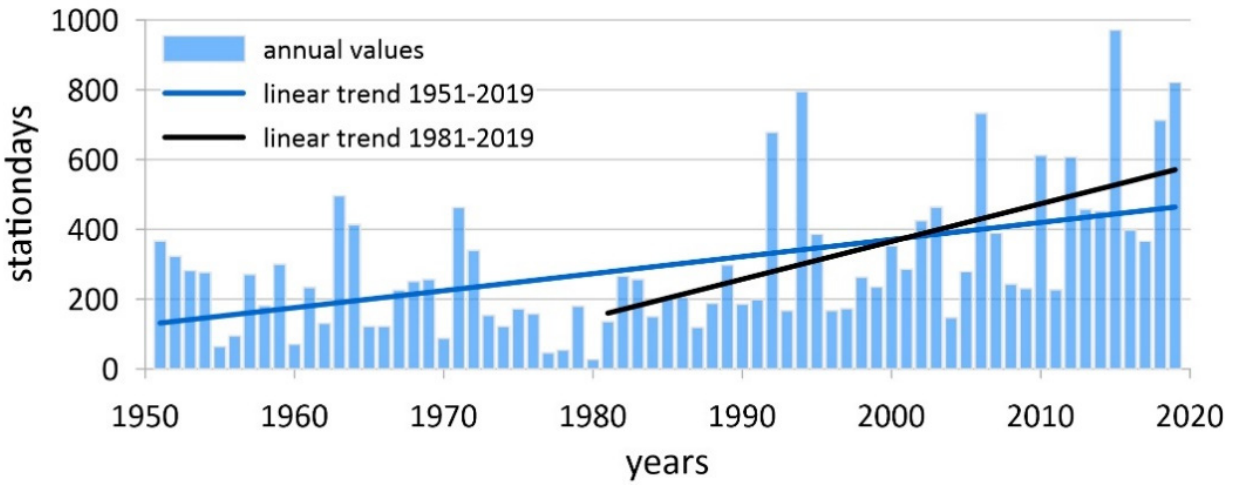
Figure 6. Annual frequencies of hot station-days in Poland in the period 1951–2019.